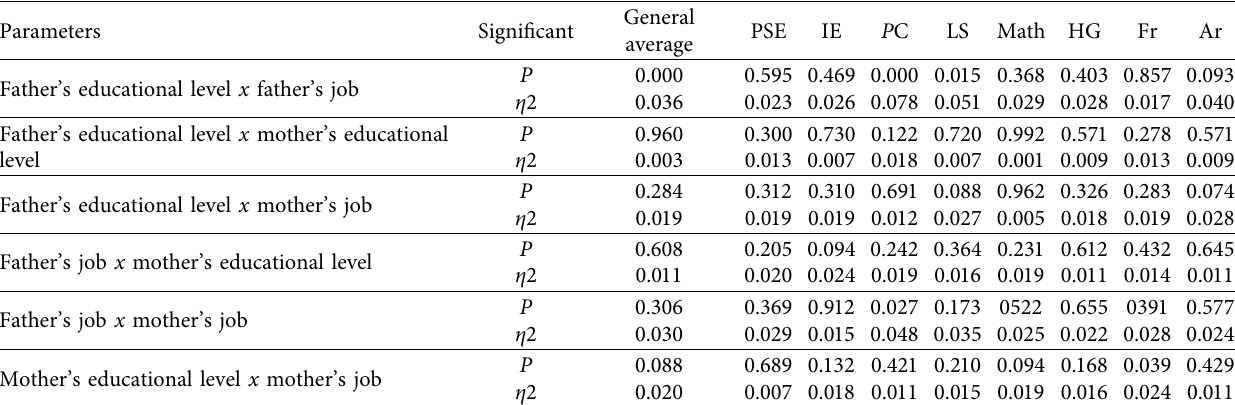
Table 6: Effect of parents’ job x their educational level on student’s academic outcomes.